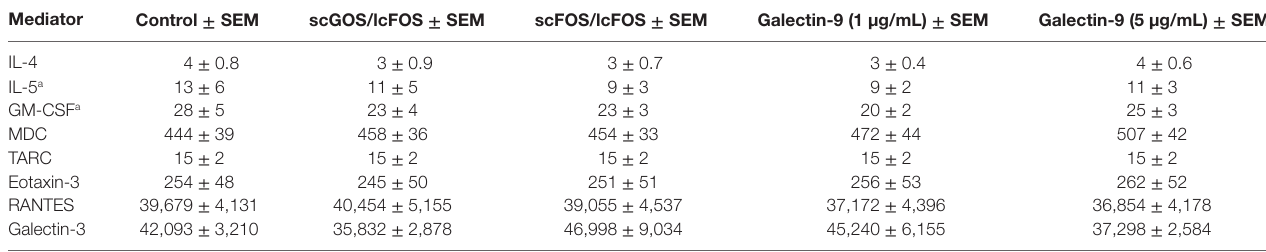
TaBle 3 | Average concentration mediators (pg/mL) in blood plasma after 24 h of pre-incubation with non-digestible oligosaccharides.